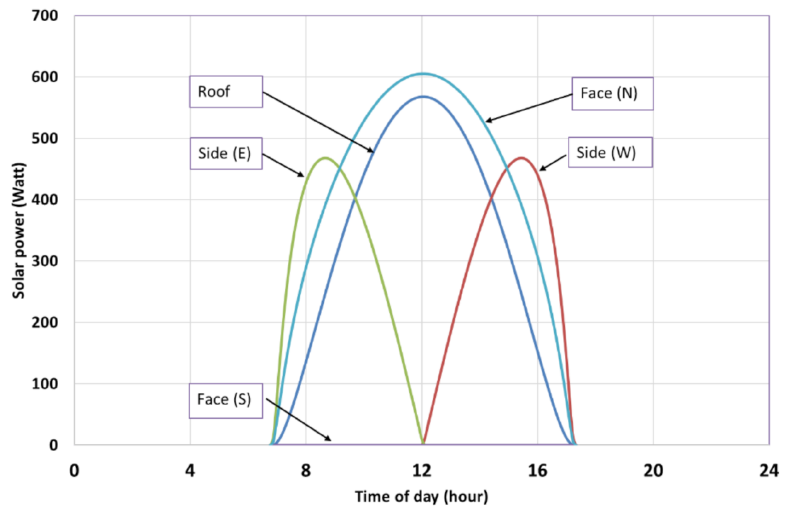
Figure 7. Solar radiation incident on the walls of the container over a winter’s day. Side (E) indicates the container side wall normal to the east, Side (W) indicates the container side wall normal to the west, Face (N) indicates the container face wall normal to the north, Face (S) indicates the container face normal to the south, and Roof indicates the roof wall of the container, which is normal to up. The incident solar radiation on the container walls follows a similar pattern to that in summer, except for the significant exposure of the north-pointing face and the reduction in the solar radiation onto the roof of the container as result of the limited sun elevation angle. The total incident solar radiation on the container walls for summer and winter is shown in Figure